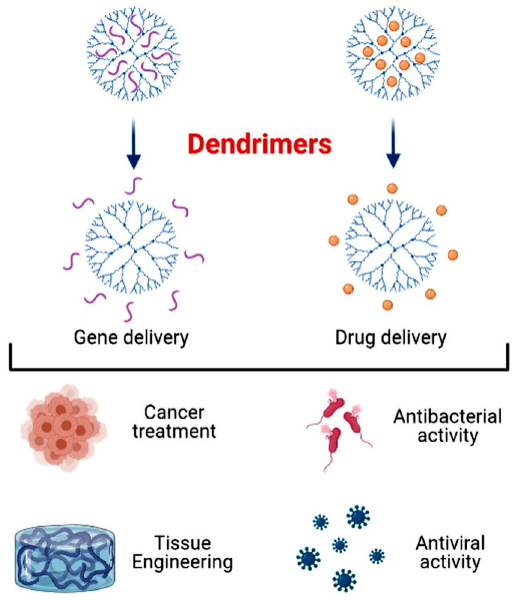
Figure 9: Dendrimers features and biomedical applications. Thanks to their ability as gene and drug delivery systems, dendrimers are amply employed in cancer treatment, tissue engineering, and anti - microbial ( bacterial and viral )